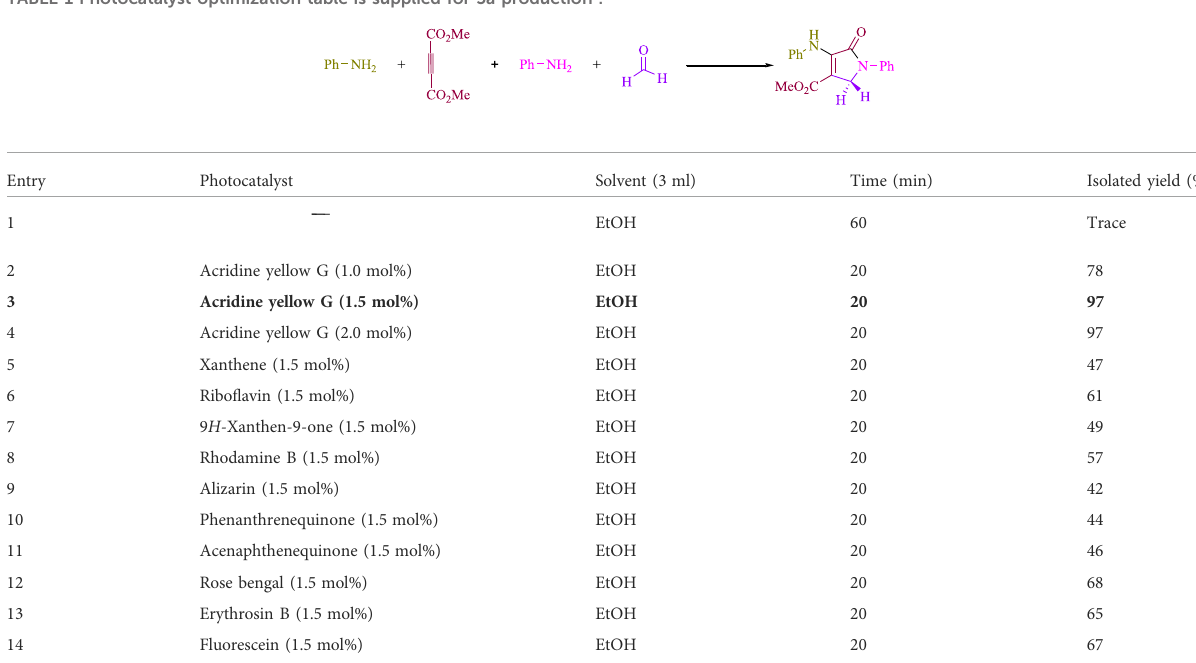
TABLE 1 Photocatalyst optimization table is supplied for 5a production a .